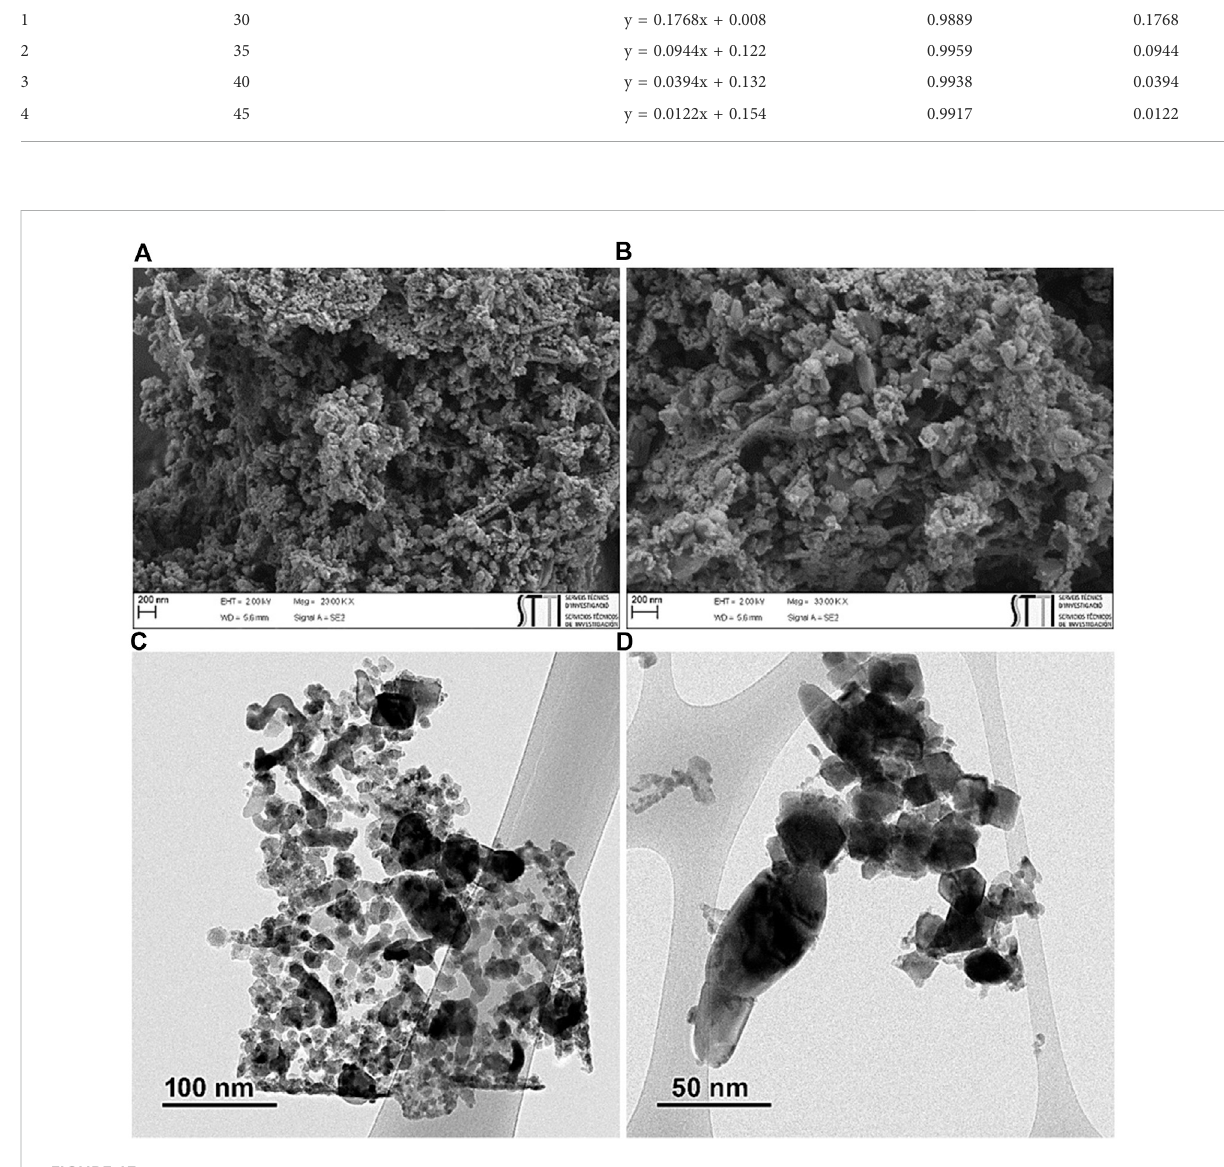
FIGURE 13 (A,B) FESEM of ZnO/NiFe 2 O 4 /Co 3 O 4 and (C,D) TEM of ZnO/NiFe 2 O 4 /Co 3 O 4 after eight times